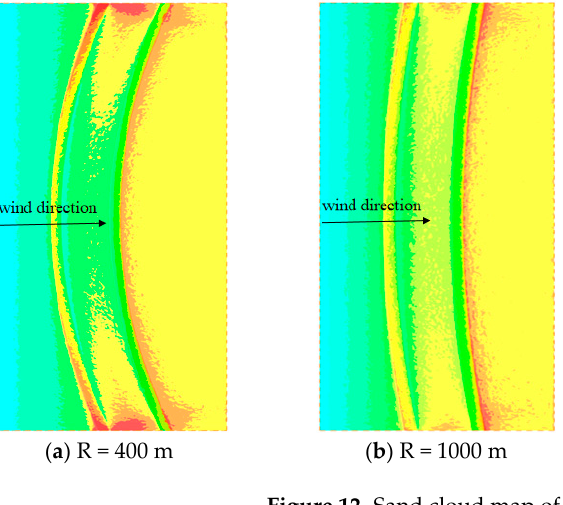
Figure 12. Sand cloud map of the convex windward embankment (t = 60 s).